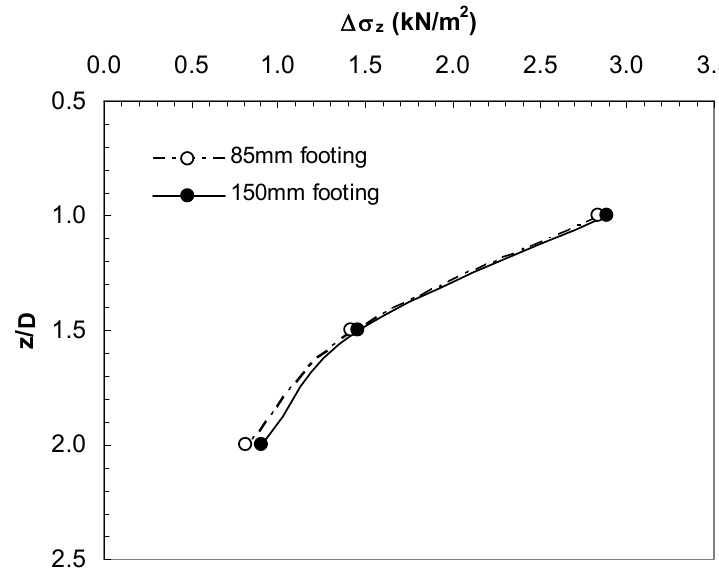
Figure 12. Vertical stress values obtained from 3DM analysis.